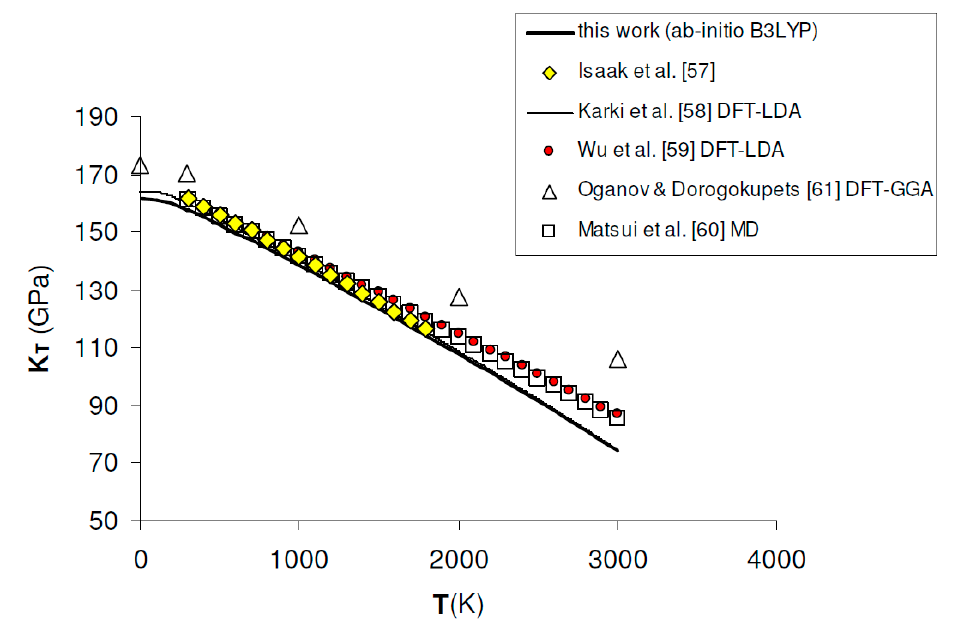
Figure 2. Ab initio B3LYP isothermal bulk modulus (K T ) of MgO. Calculated results in this work are compared to experimental data [57], other ab initio LDA [58,59] and GGA [61] calculations and semi-empirical MD simulation [60].